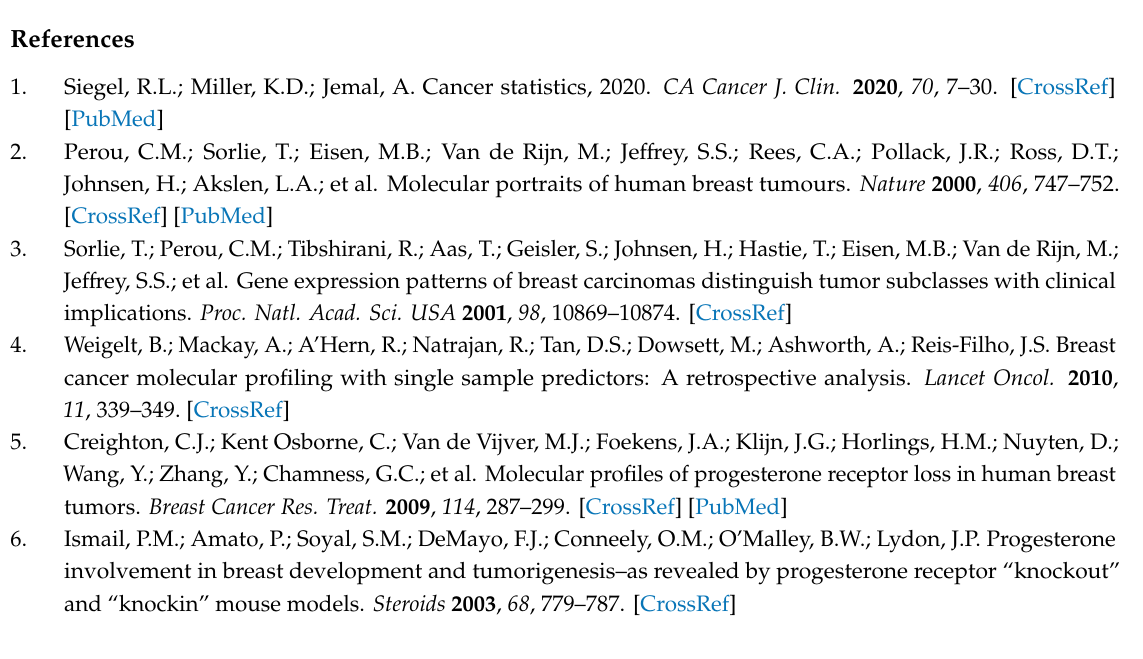
Figure S1: Expression of ZFHX3, MYC, and TBX3 in breast cell lines; Figure S2: ZFHX3 silencing in MCF-7 breast cancer cells attenuates tumor growth; Figure S3: Association of ZFHX3 expression with those of BCSC markers in di ff erent populations of MCF10A cells; Figure S4: Stable knockdown of ZFHX3 attenuates stem cell features in MCF-7 cells; Figure S5: ZFHX3 silencing reduces MYC and TBX3 expression in BT-474 and T-47D cells; Figure S6: The blank and isotype controls for the flow cytometry analysis; Figure S7: Uncropped western blot images for Figure 1; Figure S8: Uncropped western blot images for Figure 3; Figure S9: Uncropped western blot images for Figure 5; Figure S10: Uncropped western blot images for Figure S1; Figure S11: Uncropped western blot images for Figure S4; Figure S12: Uncropped western blot images for Figure S5, Table S1: Primer